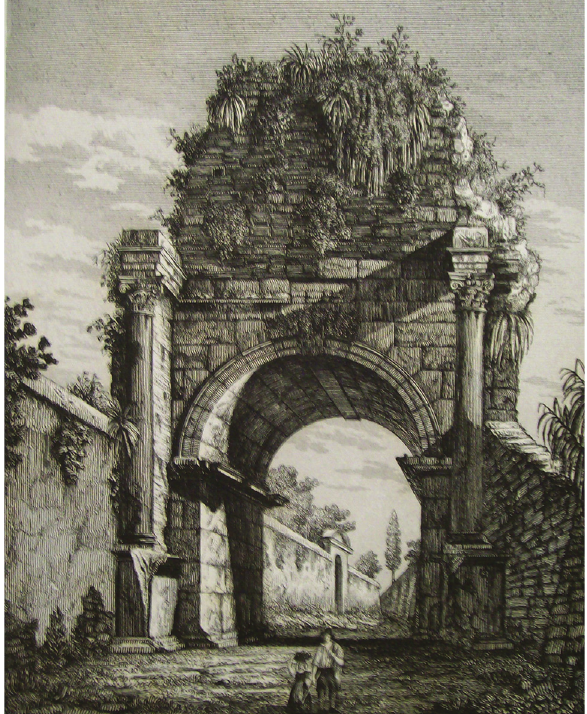
Figure 4. Southern façade of Arch of Drusus, partially enclosed by the perimeter fences of the neighbouring vines. Engraving